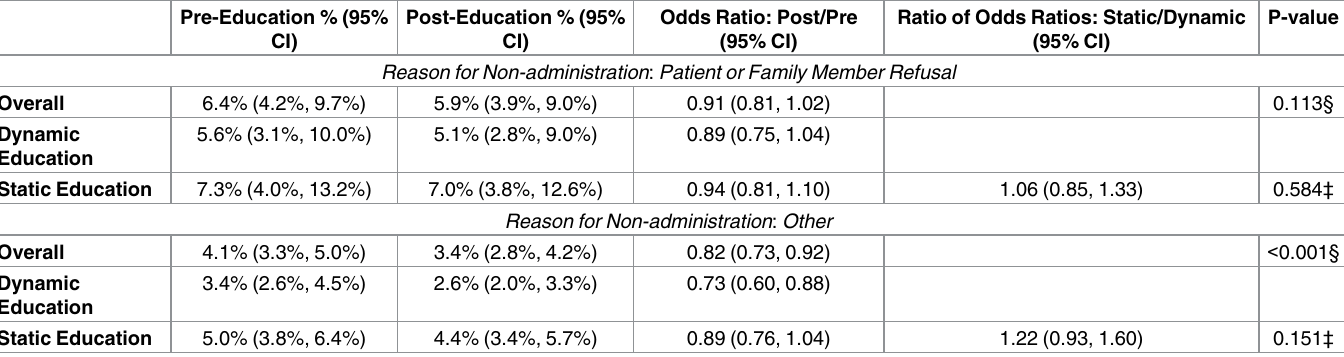
Table 3. Comparison of the reason for non-administration of prescribed venous thromboembolism prophylaxis medication doses for the dynamic and static education interventions. The Pre- and Post-Education periods are definedbasedupon the overall trainingperiod(i.e. excludingall visits within the trainingperiodregardlessof the individualnurses’trainingwith a common pre- and post-